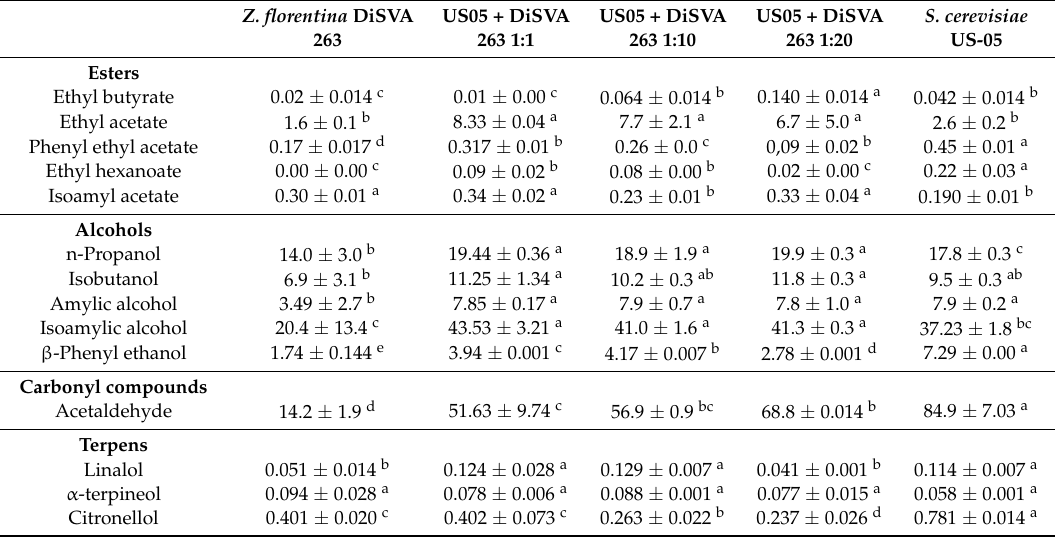
Table 4. The main by-products and volatile compounds in the beers produced by Z. florentina in the pure and mixed fermentations